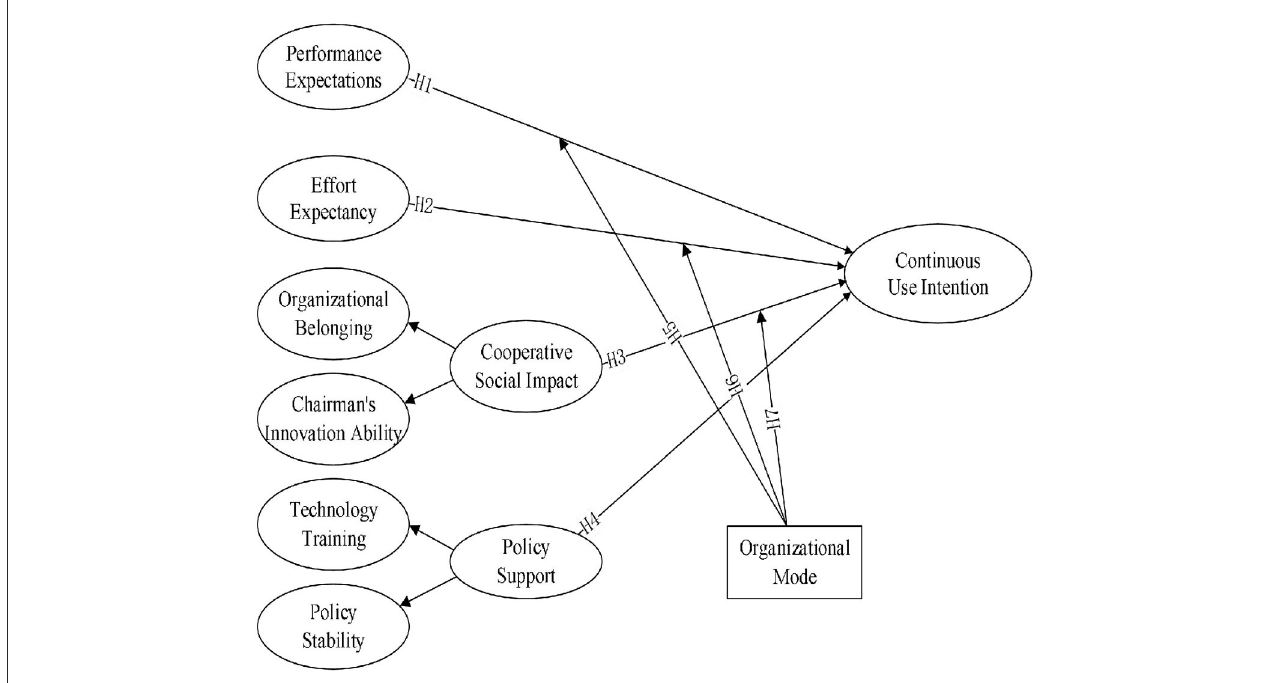
FIGURE1 Theoretical